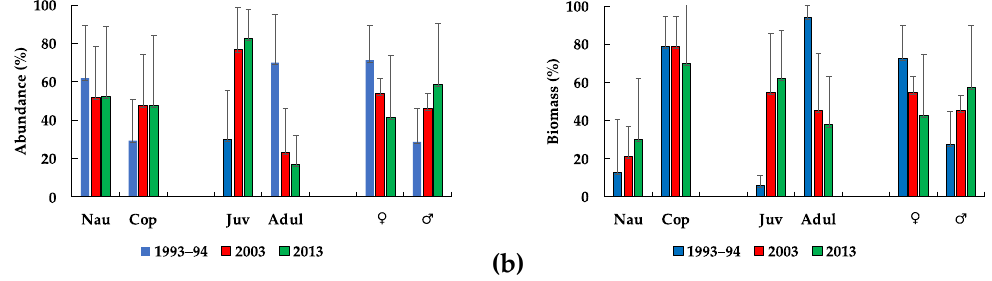
Figure 15. Abundance ( a ) and biomass ( b ) population structure of Leptodiaptomus garciai . (Nau: nauplii, Cop: copepodites, Juv: juveniles, Adul: adults, ♀ : females, ♂ : males).